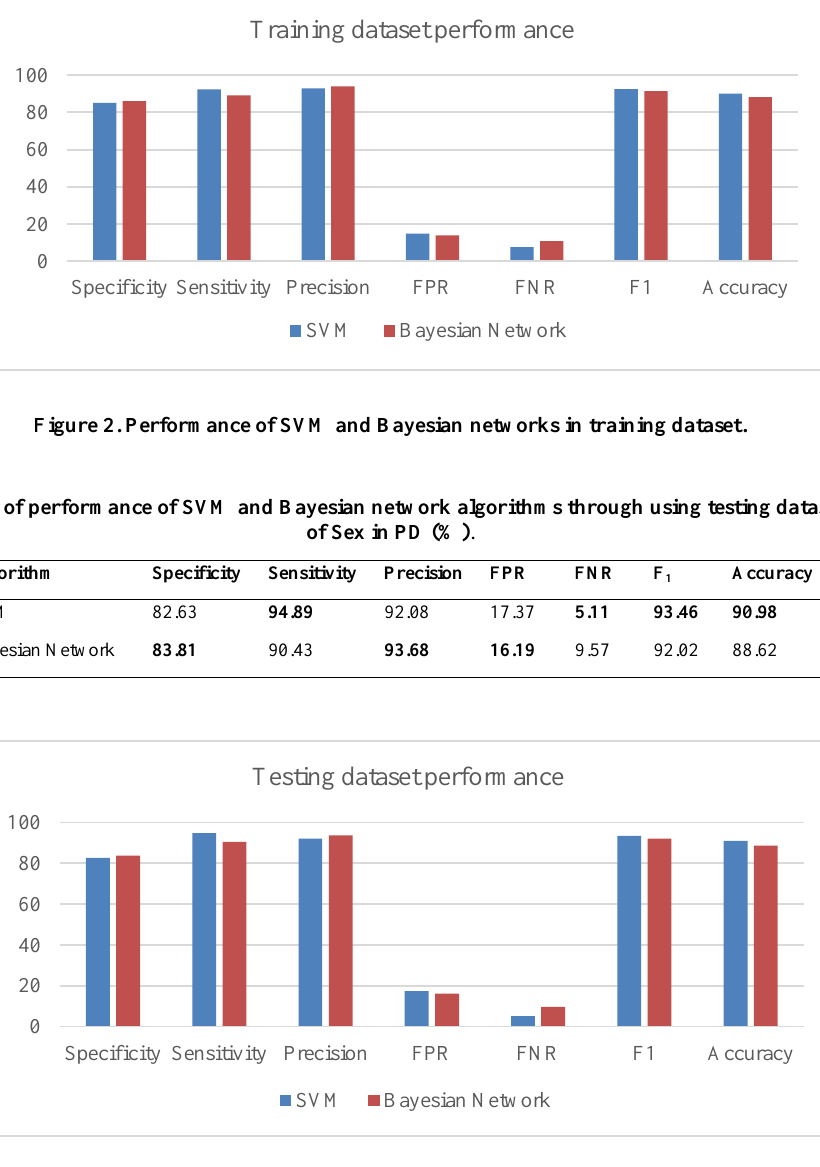
Figure 3. Performance of SVM and Bayesian networks in testing dataset.